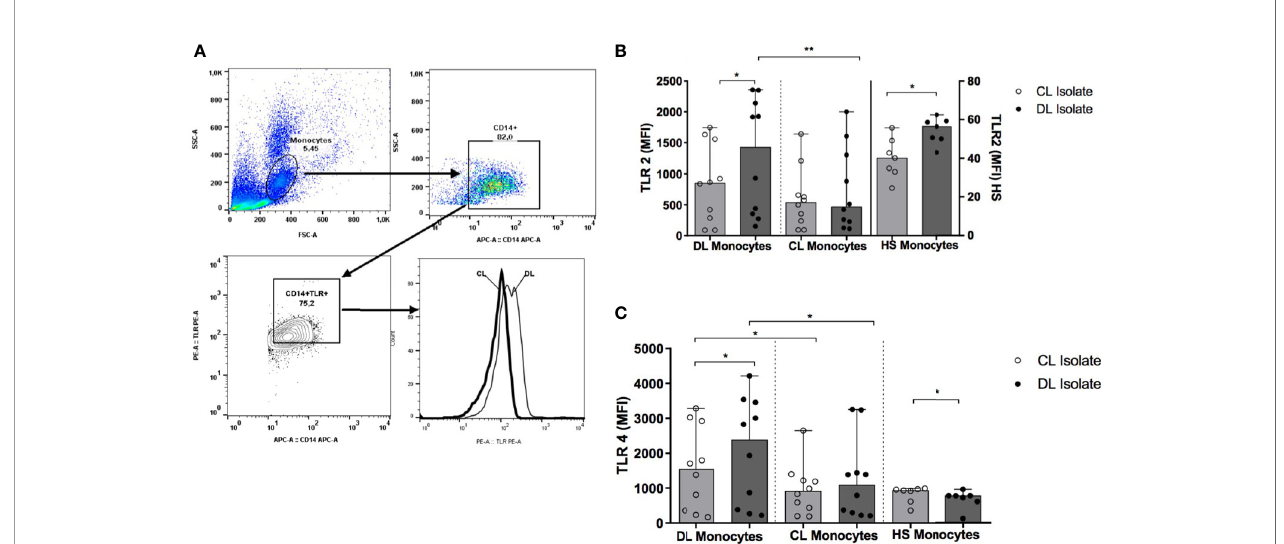
FIGURE 5 | TLR2 and TLR4 expression in monocytes from DL and CL patients. PBMC from DL (n=12), CL (n=12) and HS (n= 7) patients were infected with different isolates of L. braziliensis at a ratio of 5:1 for 2 h Following stimulation, monocytes were marked with anti-CD14 antibodies, and with anti-TLR2 or anti-TLR4 for fl ow cytometry analysis. (A) Figure representative of fl ow cytometry gating strategy; (B) Expression of TLR2 (C) Expression of TLR4. Data representative with median of mean fl uorescence intensity (MFI) values. All p values were obtained using Wilcoxon ’ s signed-rank testing; comparisons between groups made using the Mann- Whitney statistical test. (*p < 0.05) (**p <